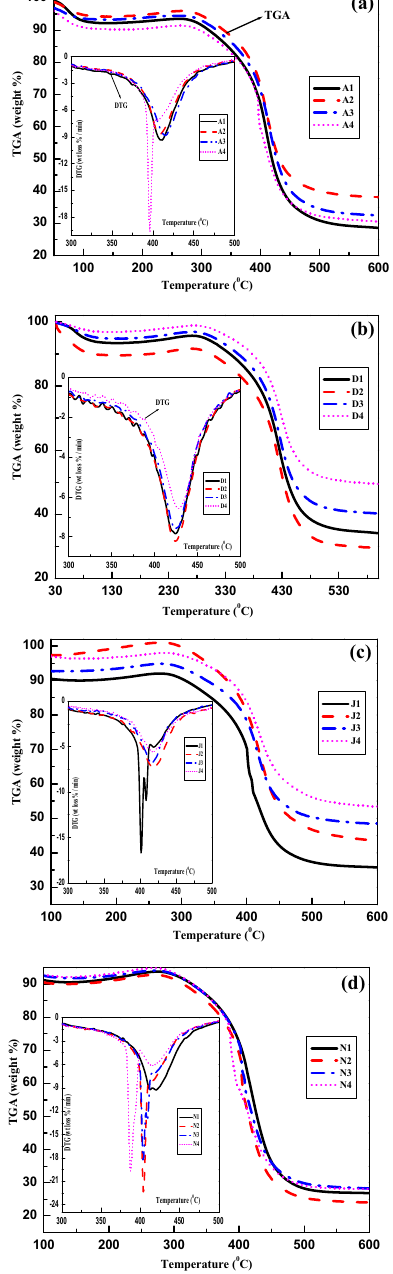
Fig. 1 TG-DTG curve of different coal sample a A1–A4, b D1–D4, c J1–J4, d N1–N4, at constant heating rate of 10 (cid:3)